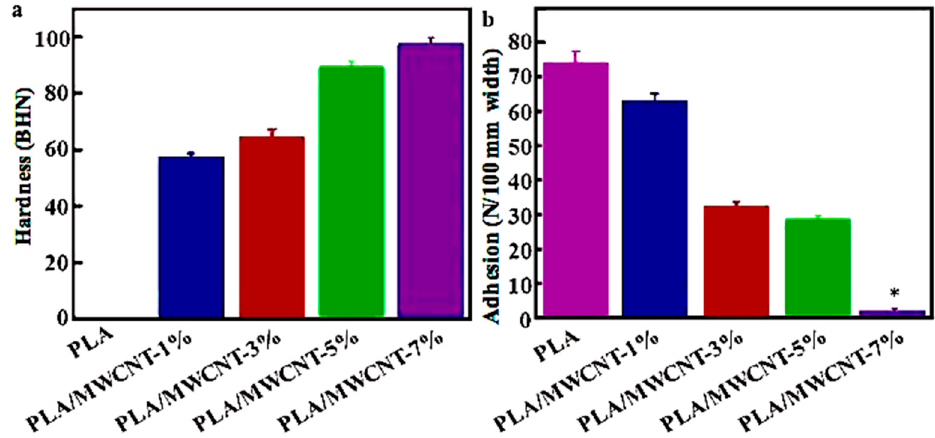
Figure 5. ( a ) Hardness, ( b ) adhesion of the extruded PLA/MWCNTs samples containing different amounts of MWCNTs.